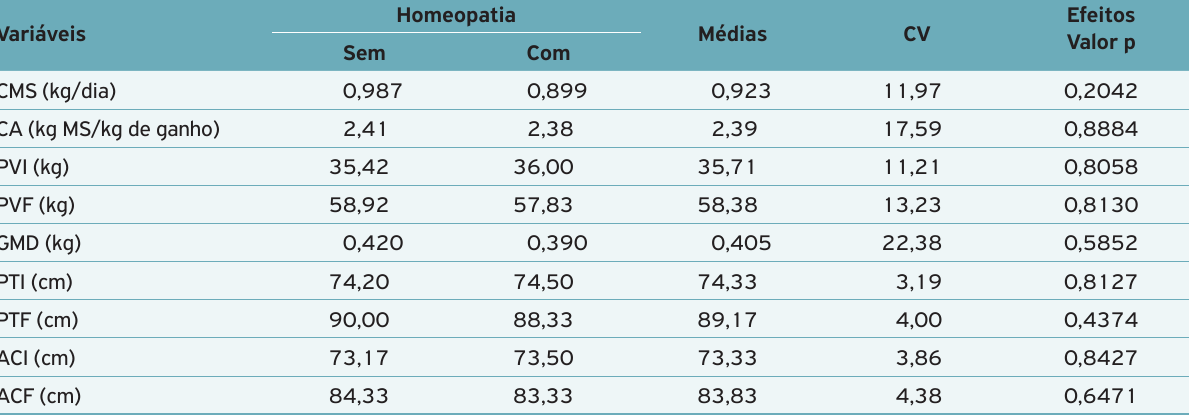
Tabela 1. Consumo de matéria seca, conversão alimentar, ganho médio diário por animal, peso vivo inicial e final, perímetro torácico inicial e final, altura da cernelha inicial e final e as respectivas médias, coeficiente de variação e valores de probabilidade em bezerras na fase de aleitamento (0 a 56 dias de idade) (Colina, SP).